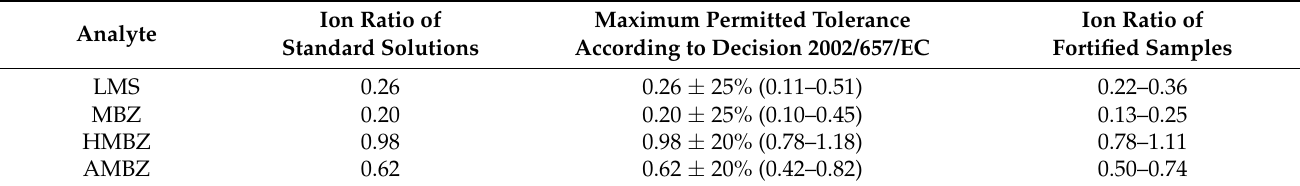
Table 2. Ion ratios of two transition reactions of the four analytes in standard solutions and spiked